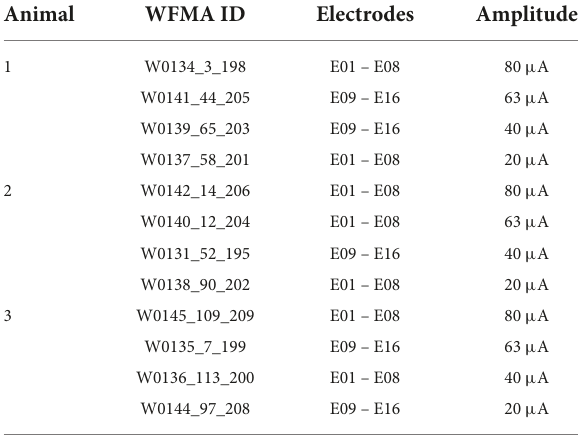
TABLE 4 WFMA IDs and electrode group assignments for pulsing in